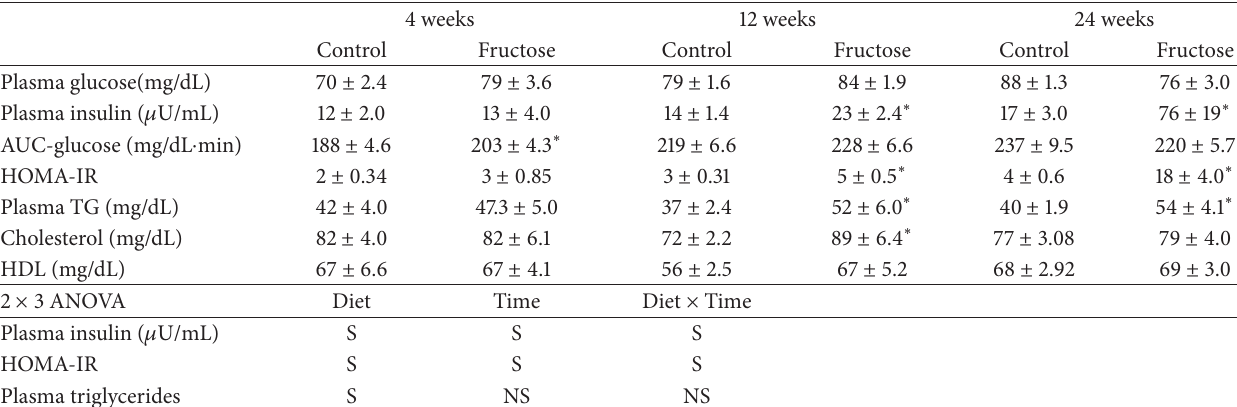
Table 1: Plasma parameters.